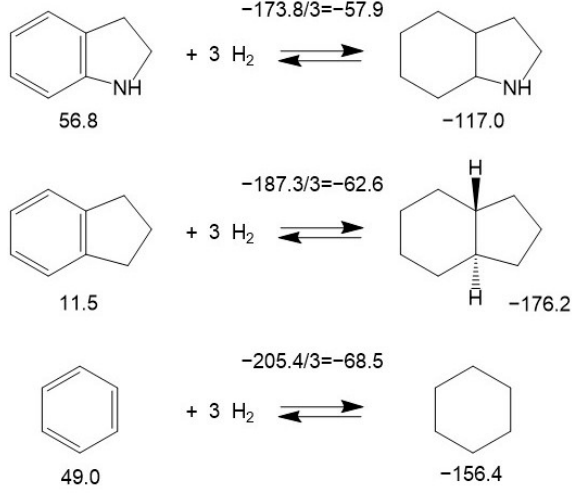
Figure 8. Comparison of the energetics of hydrogenation of three double bonds in the benzene ring of indole, in indane and in benzene. Figures below molecules are ∆ f H o m (liq) taken from Table S2. Figures above the arrows are ∆ r H o m (liq) calculated according to Equation (1) and divided by the number of double bonds. All values are in kJ·mol − 1 .